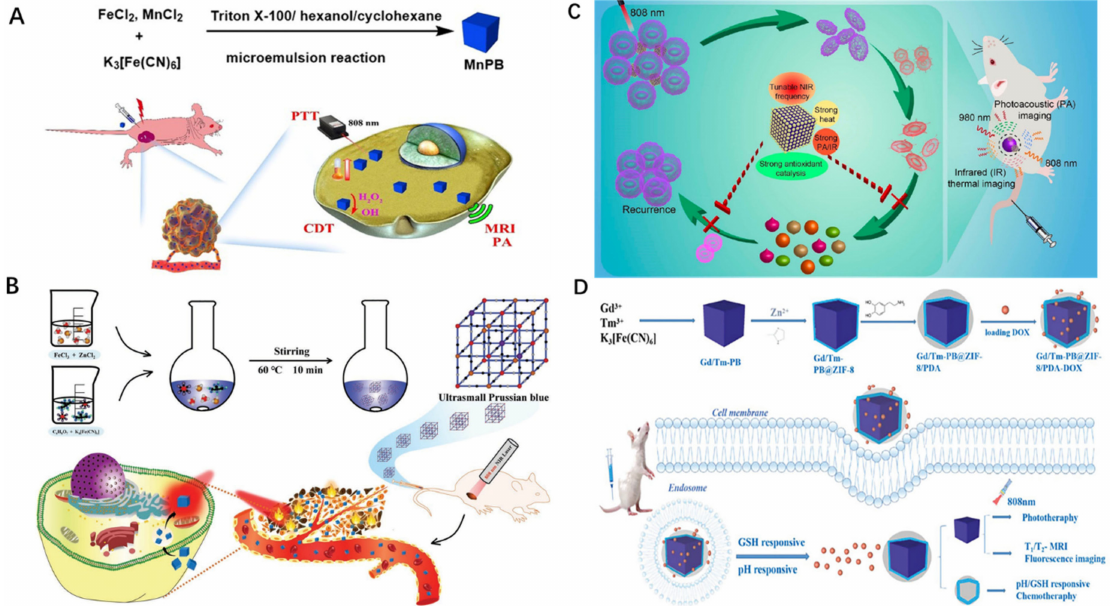
Figure 8. ( A ): MnPB NPs scheme for T1/T2 weighted MR imaging, PA imaging, and CDT/PTT co − therapy in cancer [35]. ( B ): Zn 2+ doping to produce ultra − small PB nanoprobes with PTT and MRI characteristics [36]. ( C ): Pt-PBzyme as a photothermal agent to reduce inflammation and treat intricate tumor diseases [40]. “Reprinted (adapted) with permission from [40]. Copyright [40] American Chemical Society”. ( D ): The Gd/Tm − PB@ZIF − 8/PDA platform with the best particle size, fluorescence, and photothermal effects [38]. Copyright application has been